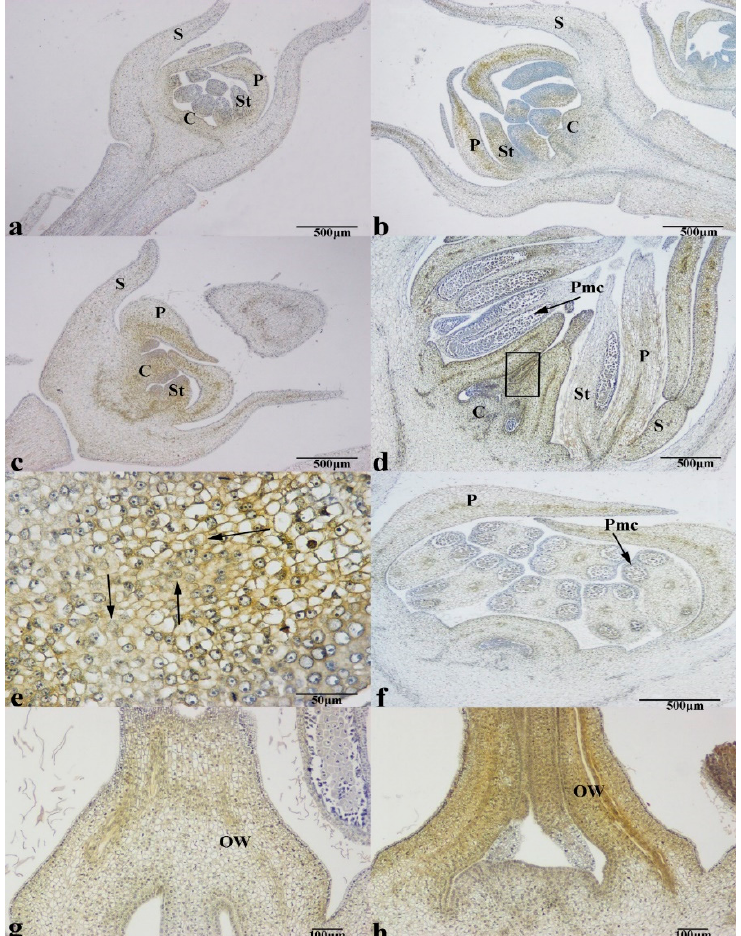
Figure 7. Cyt-c immunohistochemical (IHC) expression of male floral buds during differentiation in persimmon. ( a – c ) Immunostaining of cyt-c as brown staining in the pistil primordium at the carpel primordium differentiation stage in tissues harvested on April 5, 2017, the anther primordium differentiation stage in tissues harvested on April 8, 2017, and the pollen sacs and filaments stage harvested on April 11, 2017 increased gradually. ( d ) The highest expression of active cyt-c was detectable at the microsporocyte stage in the pistil primordium in tissues harvested on April 14, 2017. ( e ) Image of the pistil primordium from the rectangle magnified in ( d ) (arrows indicate dead cells with brown-labeled cytoplasm and nucleus). ( f ) Regardless of the presence of PCD in tissues harvested on April 17, 2017, the pistil primordium had already been aborted. ( g ) Negative control for the pistil primordium in male flower buds harvested on April 14, 2017, where no distinct immunohistochemical (IHC) staining of cyt-c was detected in the pistil primordium. ( h ) Pistil primordium in male flower buds harvested on April 14, 2017. Dead cells were stained brown (C = carpel; P = petal; Pmc = pollen mother cell; S = sepal; St = stamen).